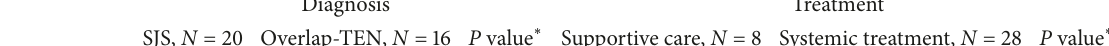
Table 4: Long-term sequel according to diagnosis and treatment. Diagnosis Treatment